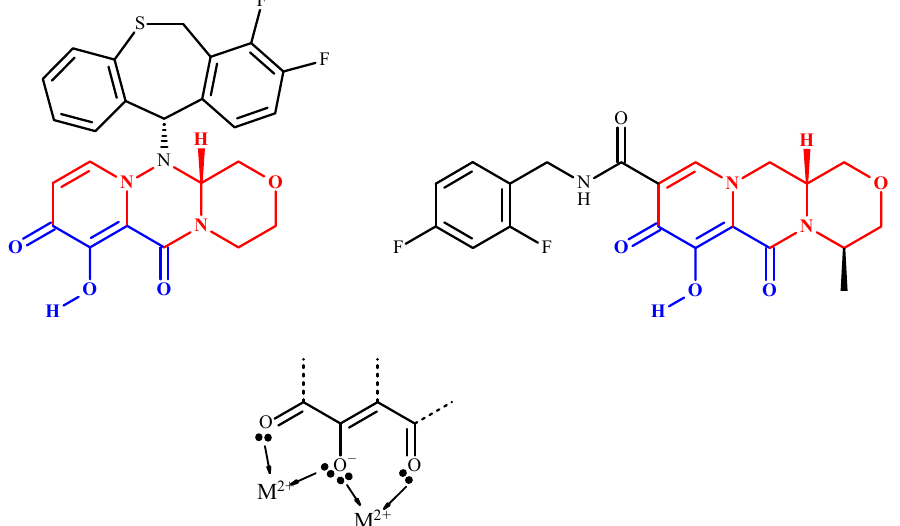
Figure 2. Structures of BXA ( left ) and dolutegravir ( right ), showing the similar tricyclic parts (red) and the metal binding keto–enol moiety (blue). Two bivalent metal ions (either Mn 2+ or Mg 2+ in the enzymes, symbolized by M 2+ ) can be chelated by the molecular pincers ( below ). Pharmaceuticals 2022 , 15 , x FOR PEER REVIEW